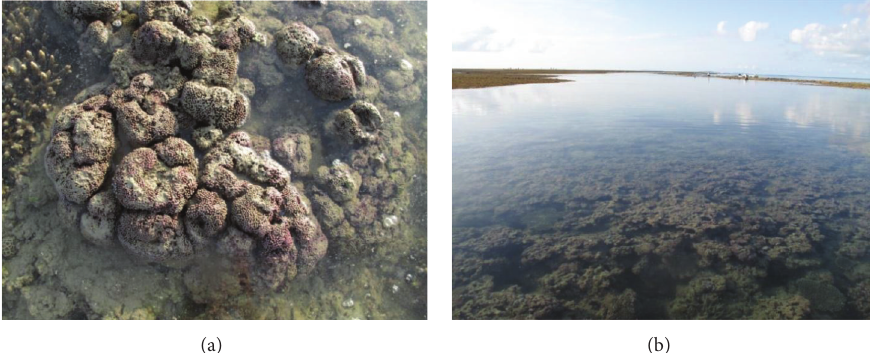
Figure 5: Organ Pipe Coral at Long Reef. (a) A single colony of Organ Pipe Coral ( Tubipora sp.). (b) The narrow fore-reef habitat on the western side of Long Reef showing the prolific development of Tubipora as the tide